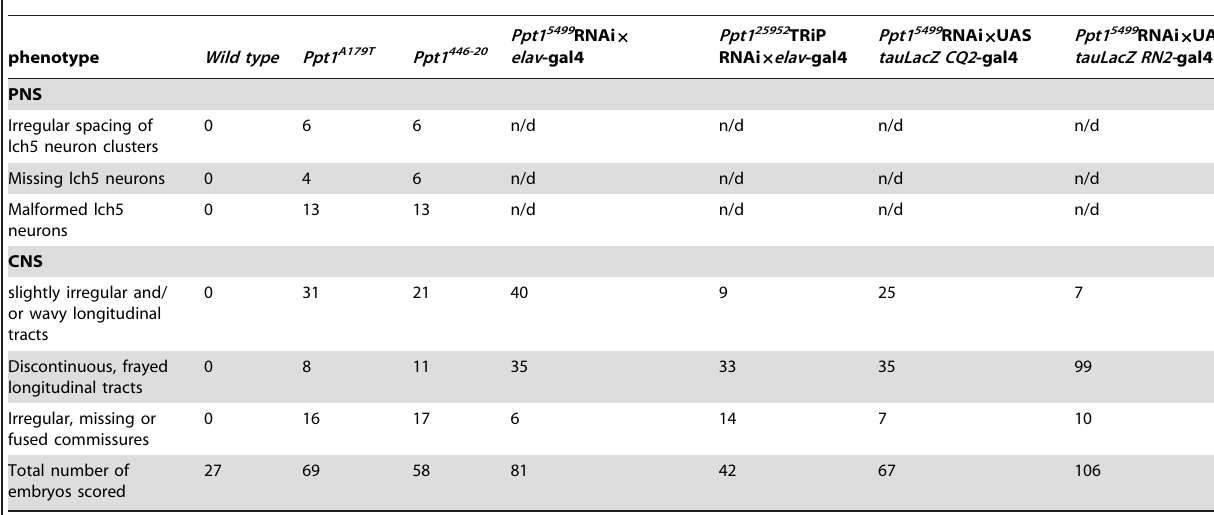
Table 5. Quantitation of Ppt1 axon defects in the embryonic CNS and PNS.